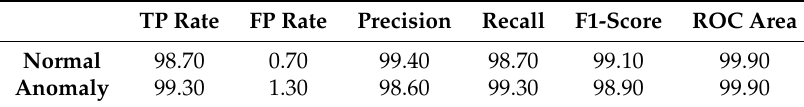
Table 32. Classification report for Adaboost Random Forest.